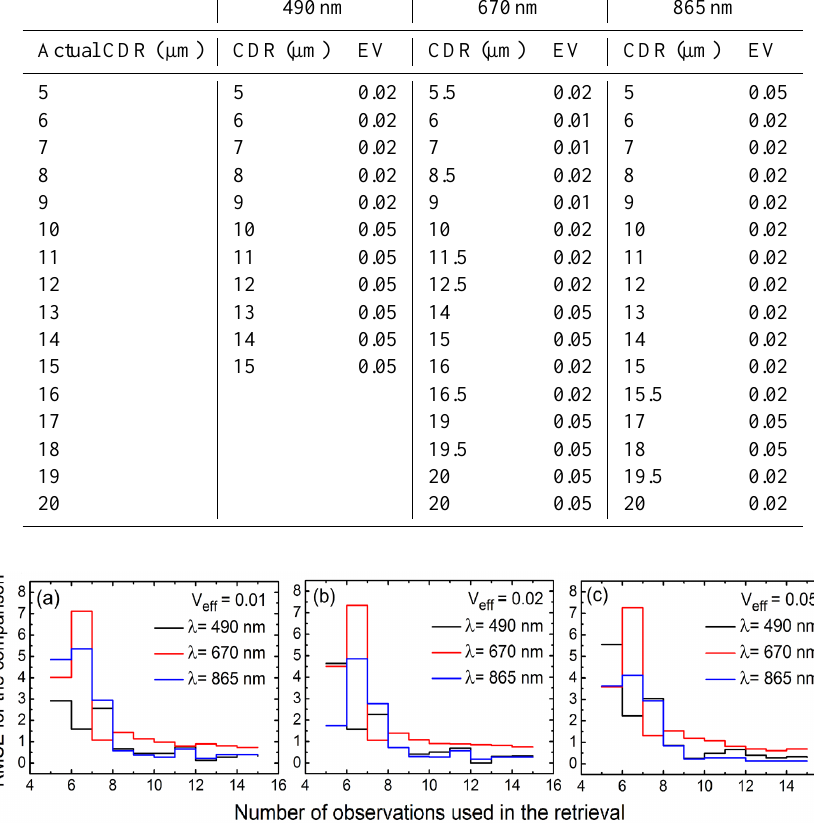
Figure 6. Comparisons of RMSE for the CDR retrievals using different numbers of observations at wavelengths of 490, 670, and 865nm and for EVs of 0.01, 0.02, and 0.05, respectively. The COT was assumed to be 5 in all